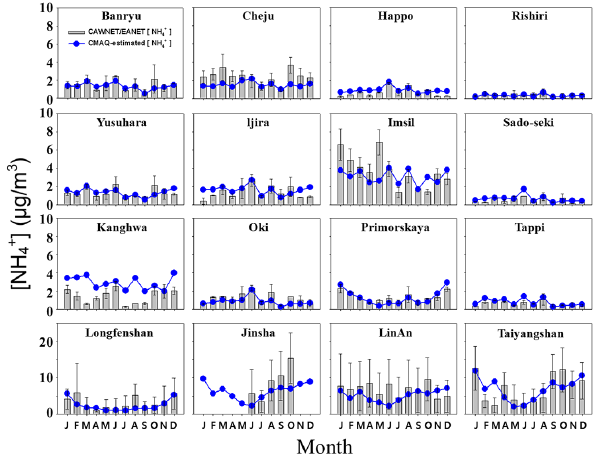
at 16 EANET/CAWNET sites. 4